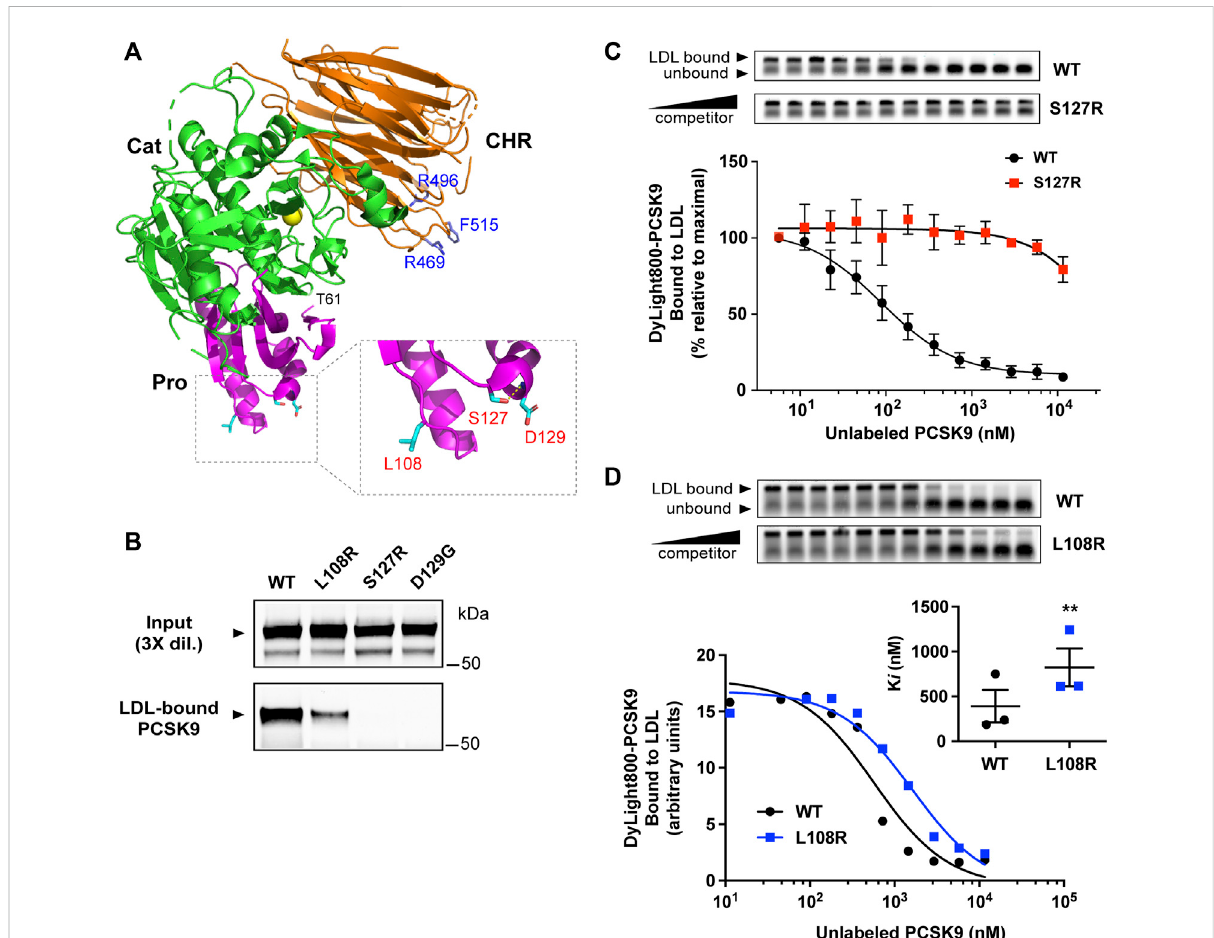
FIGURE 2 GOF mutations in the PCSK9 prodomain inhibit LDL binding function. (A) Crystal structure of PCSK9 (PDB ID: 2QTW) (Hampton et al., 2007) generated with PyMOL (http://www.pymol.org). Color scheme: Prodomain (Pro, magenta), catalytic domain (Cat, green), CHR domain (orange). Highlighted in blue are residues in the CHR domain affected by PCSK9 GOF mutations known to inhibit LDL binding (Sarkar et al., 2020). Box: details of prodomain region showing close proximity of residues associated with FH. Side-chain sticks of L108, S127, and D129 are highlighted (cyan). Also depicted is a hydrogen bond involving the side-chain of S127 and main-chain amino group of D129 (yellow broken line). (B) Conditioned cell culture medium containing 1.0 μ g/ml wild-type PCSK9 (WT) or indicated mutants were incubated with PCSK9-free human LDL (0.5 mg/ml) prior to density gradient-ultracentrifugation and immunoprecipitation and Western blot analysis of LDL-containing fractions. Shown is a representative experiment ( n = 3) (C) Competition binding of WT-PCSK9 and S127R mutant PCSK9 to LDL. Dylight800-labeled WT-PCSK9 was incubated with LDL in the presence of increasing concentrations of unlabeled PCSK9. Reaction mixtures were separated on agarose gels ( top ) and fl uorophore-labeled PCSK9 binding to LDL was quanti fi ed and fi tted to competition binding curves using non-linear regression ( n = 3) ( bottom ). (D) Competition binding of WT-PCSK9 and L108R mutant PCSK9 to LDL. Analysis was carried out as in (C) and shown is a representative experiment. Inhibitor constants (Ki) obtained from curves are graphically represented ( inset ). Error bars represent SEM ( n = 3). Signi fi cant change in LDL binding of L108R